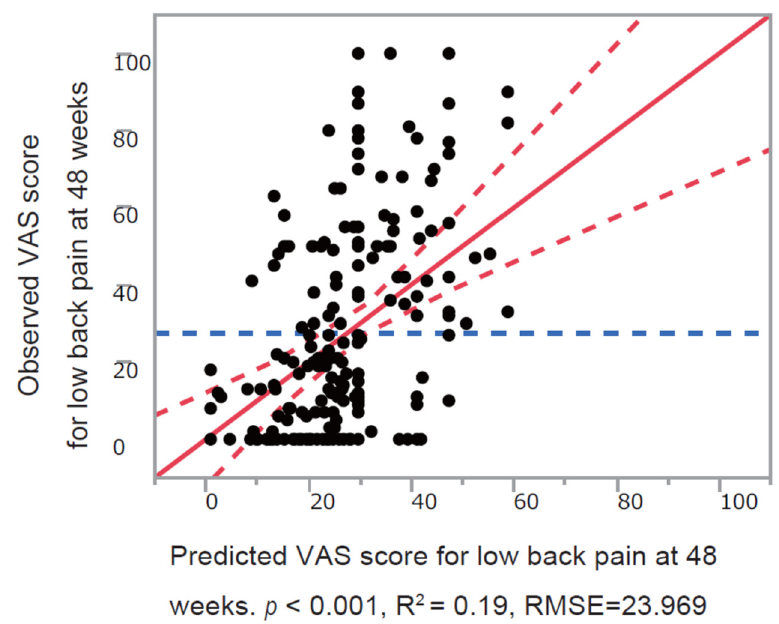
Figure 2. Observed versus predicted plots of multiple linear regression model for the VAS score for low back pain (48 weeks). The red line indicates regression line. The red dashed curve indicates a 0.05 level of significance. The blue dashed line indicates the mean VAS score for low back pain at 48 weeks. RMSE, Root mean squared error, VAS, visual analog scale.